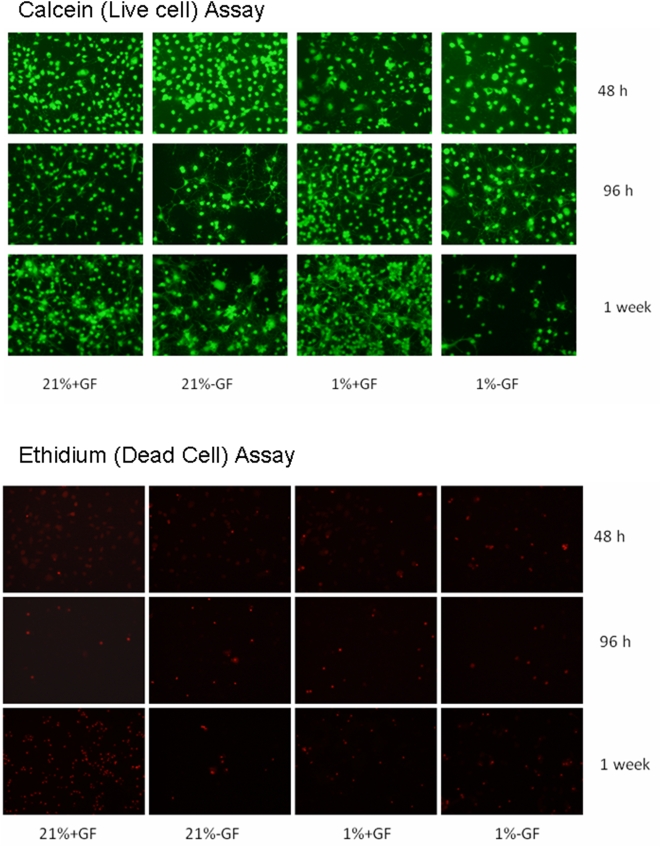
Hypoxia influences on cell viability.Images of calcein (live) and ethidium (dead) cells labeled OLs cultured in the presence or absence of GFs in 21%2, 4% or 1% O2 for 48 hrs, 96 hrs, and 7 days. Images shown are representative of 4 separate studies.